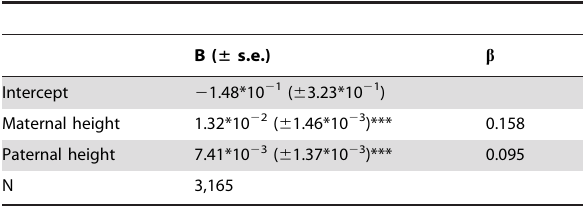
Table 2. Linear regression parameter estimates of the effects of maternal height and paternal height on birth weight.